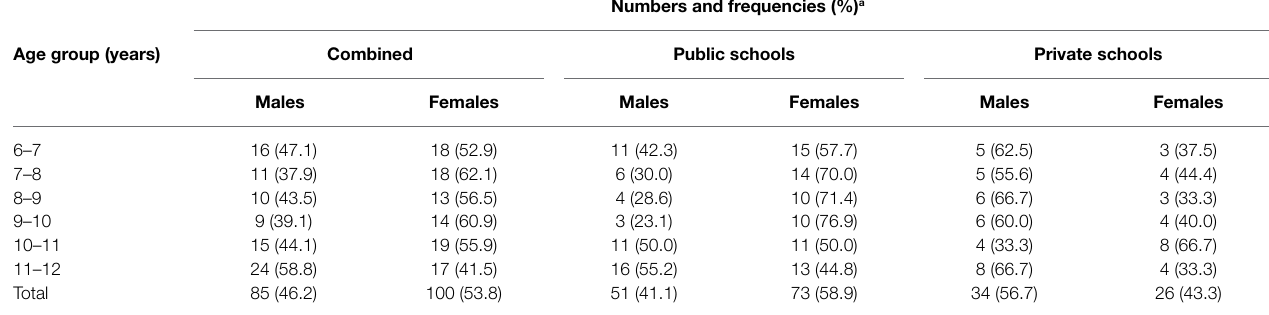
TABLE 1 | Distribution of the sample in the study by age and gender.